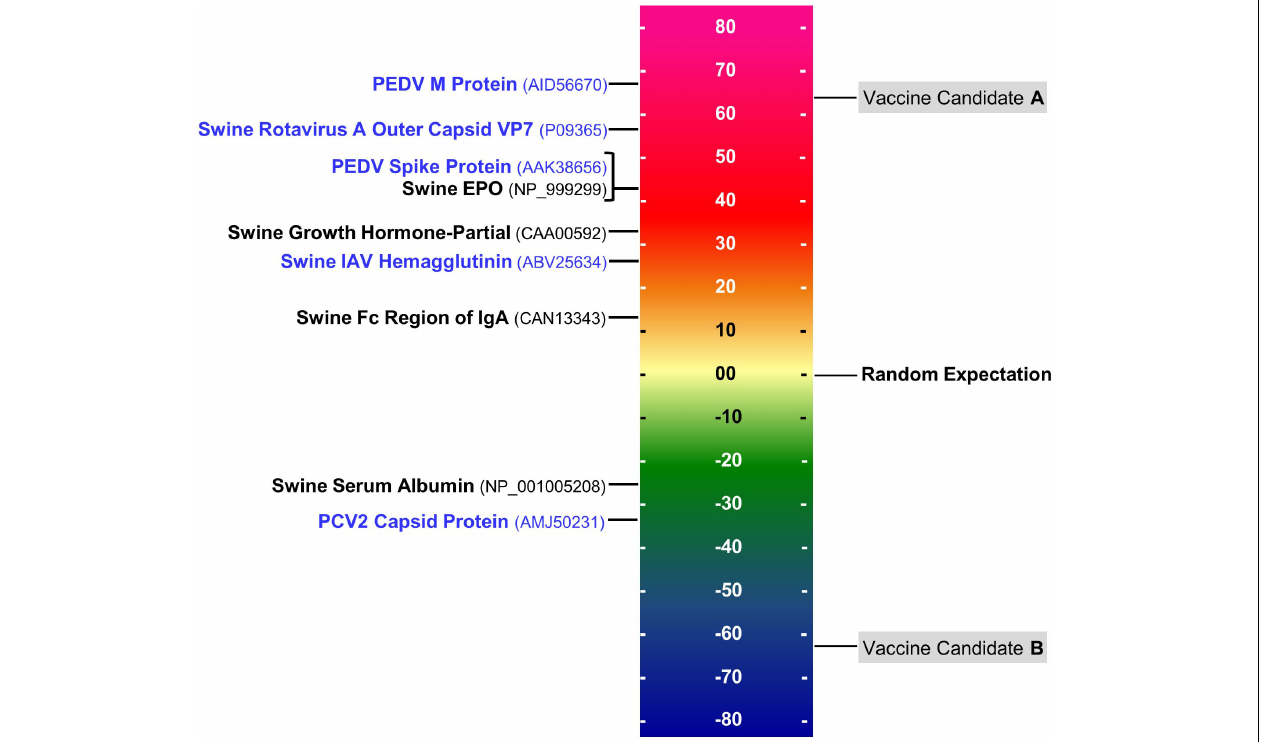
FIGURE 2 | EpiMatrix immunogenicity scale. The immunogenicity scale shows swine pathogen antigens that have been reported to be immunogenic, and non-immunogenic antigens. Sequence accession numbers in GenBank are provided in the parentheses. The EpiMatrix immunogenicity scale is set to zero based on the average epitope content in a randomly generated protein sequence. Normalization of SLA scoring enables the ranking and direct comparison of candidate antigens; for example, candidate vaccine antigen A would be preferred over candidate vaccine antigen B for inclusion in a vaccine designed to elicit T helper immune response and to drive humoral